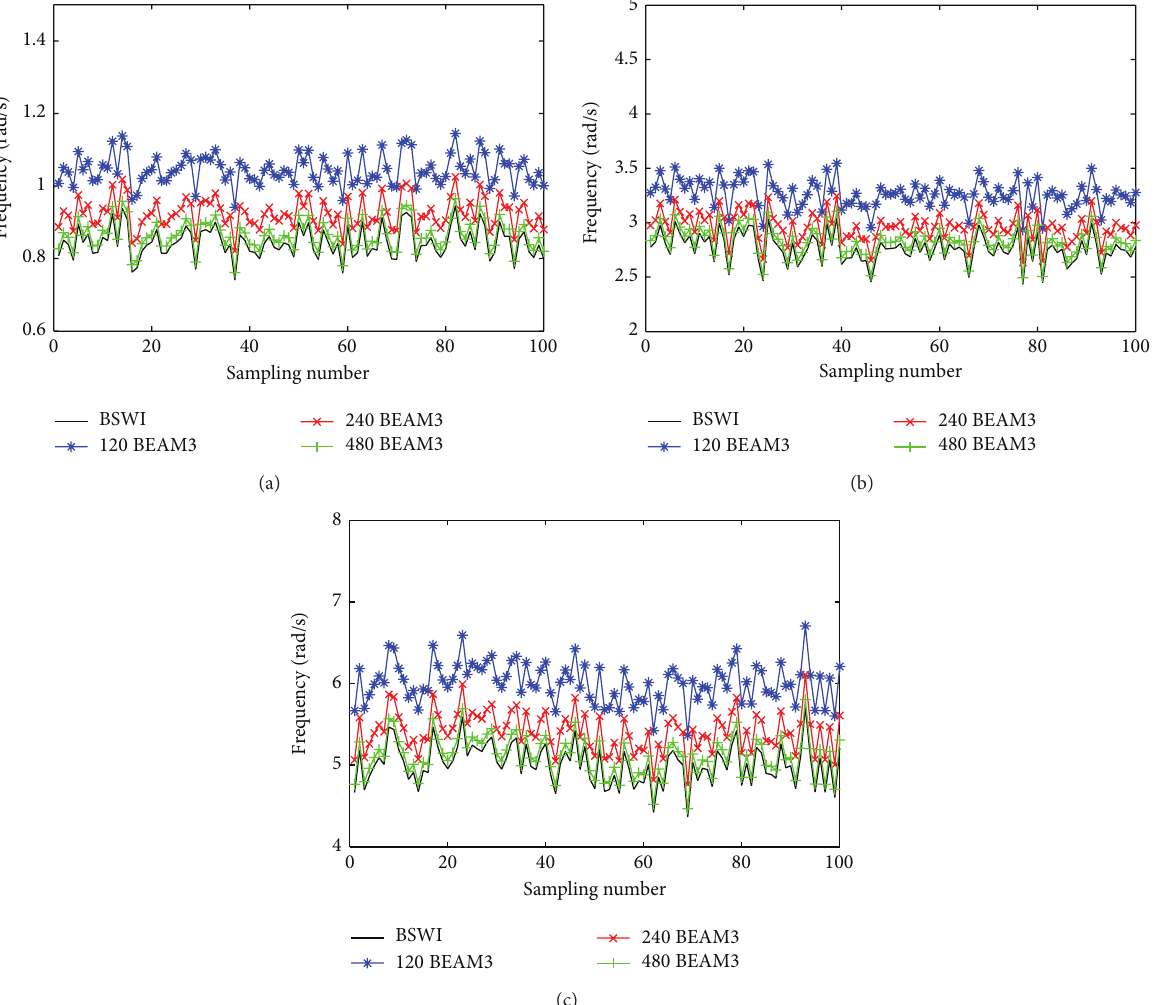
Figure 17: Relationship between the first three natural frequencies and sampling numbers of plane rigid frame. (a) First-order circular frequency, (b) second-order circular frequency, and (c) third-order circular